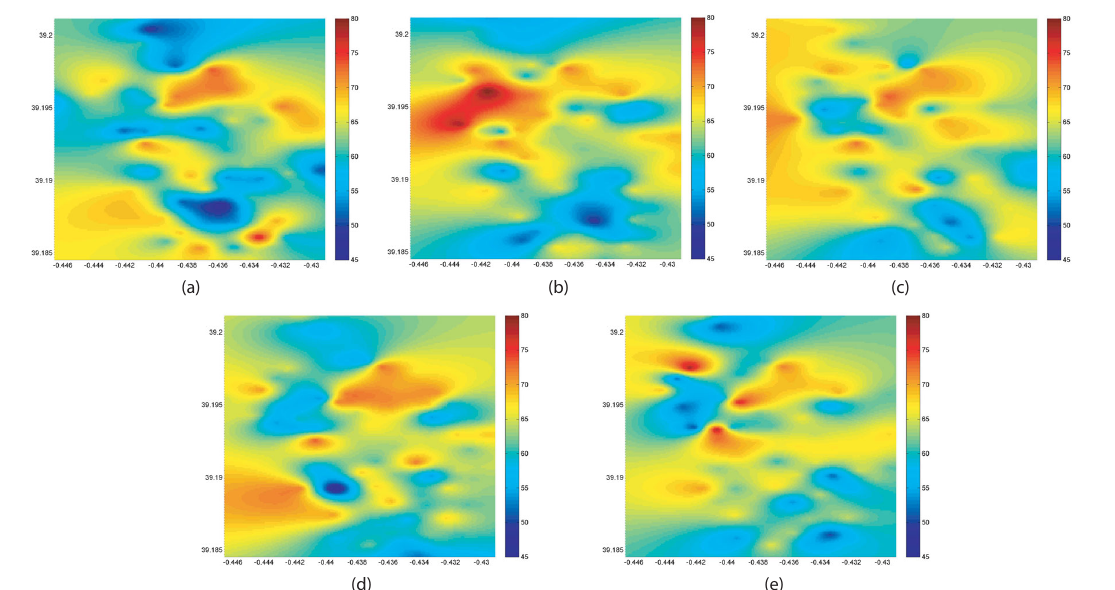
Figure 8. Interpolated noise levels per time period: ( a ) 7–10 h; ( b ) 10–13 h; ( c ) 13–16 h; ( d ) 16–19 h and